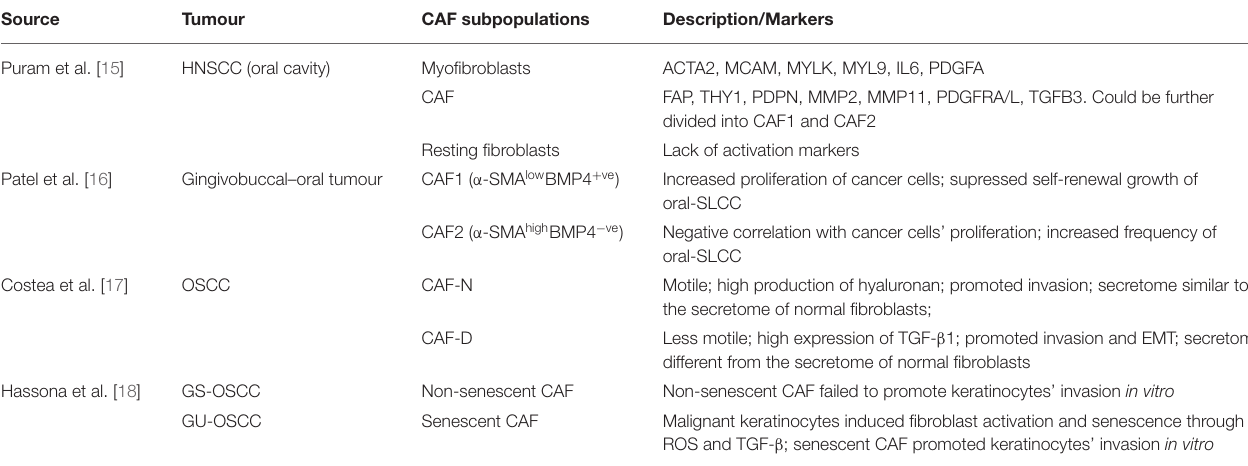
TABLE 1 | Heterogeneity of CAF in oral